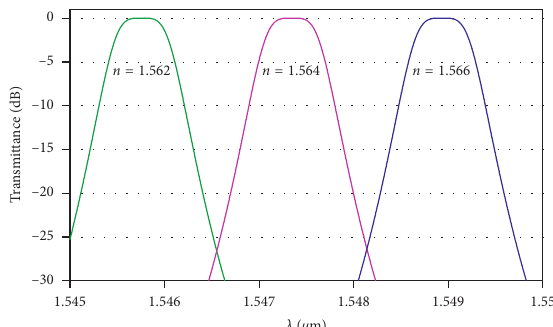
Figure 6: The transmission intensity for different values of the LC refractive